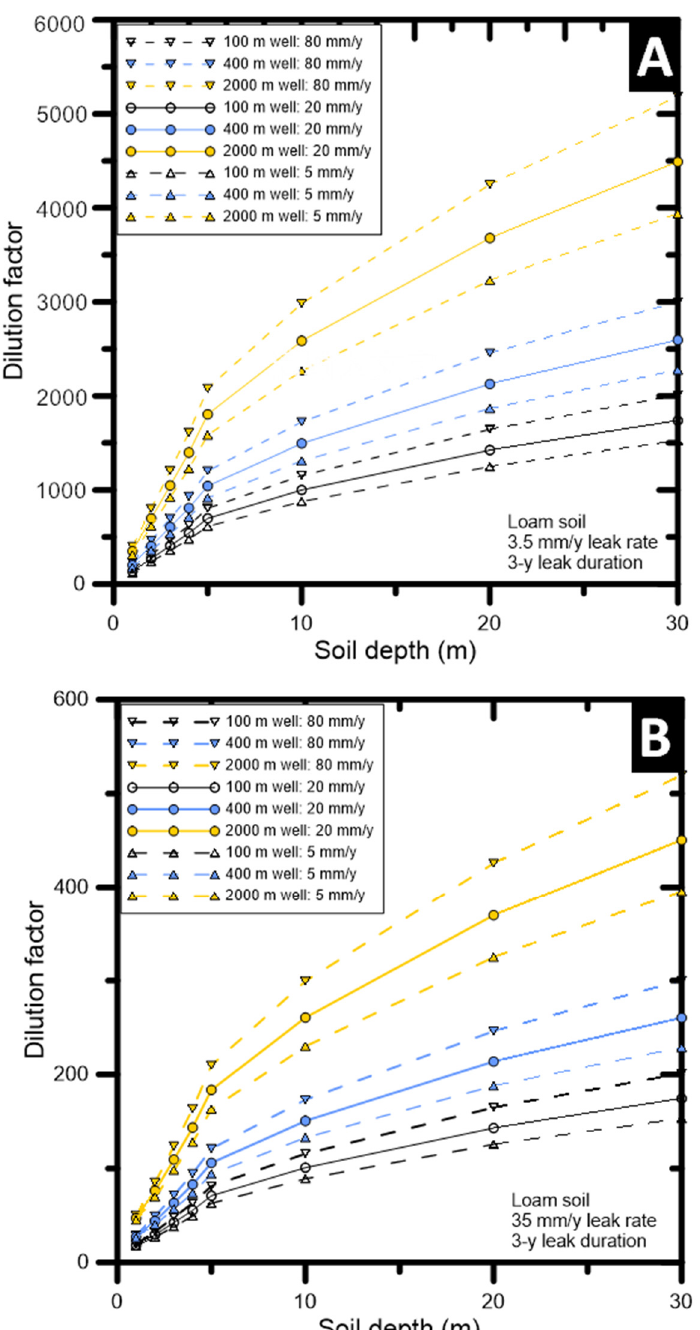
Figure 9. Combined dilution factor ( DF ) for loam soil and groundwater pathway. Reference groundwater conditions used. Loam soil with three recharge rates and leak rates of 3.5 mm/year (A) and 35 mm/year (B).